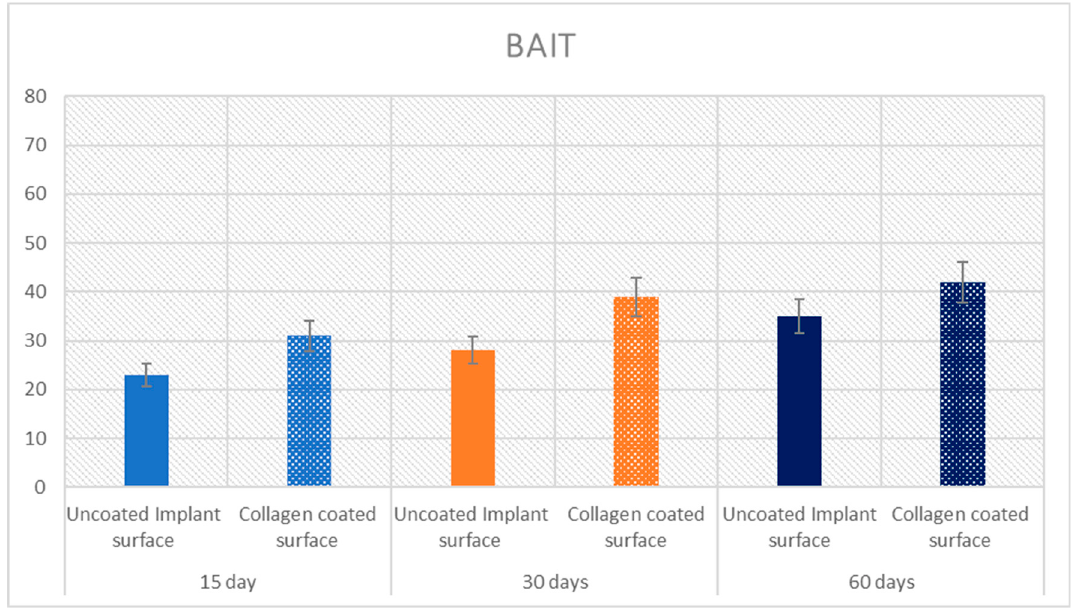
Figure 10. Means and SD of the measured BAIT ratios at 15, 30 and 60 days. Y axis is BAIT expressed in %.